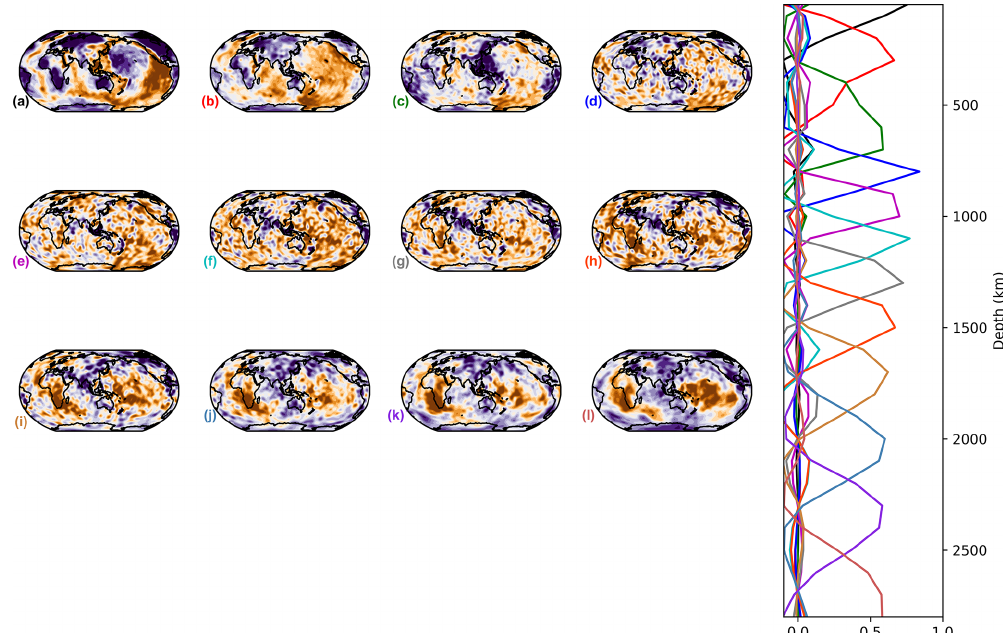
Figure C4. The 12 varimax components of the S40RTS